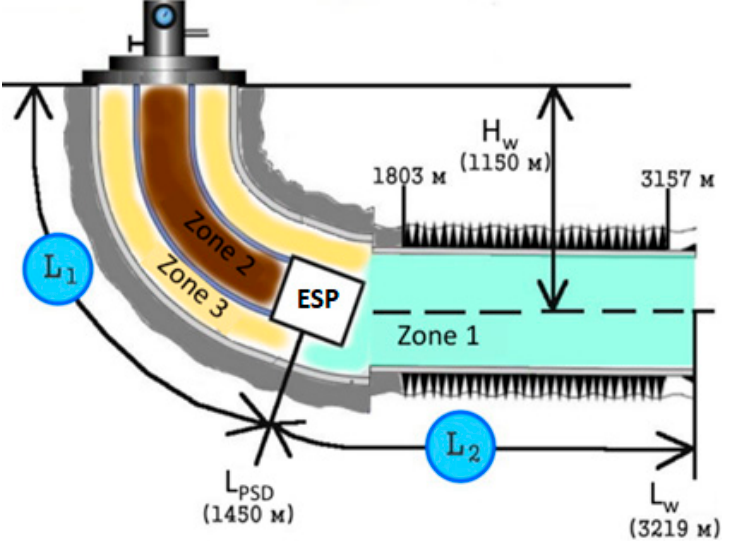
Figure 2. Schematic of the standard well on «Training» field.